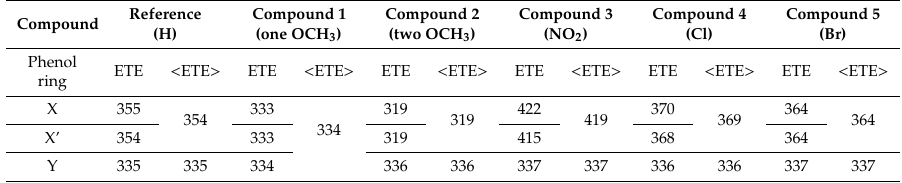
Table 4. Calculated electron transfer enthalpy (ETE) values (kJ / mol) of the phenol rings (X, X’ and Y) in